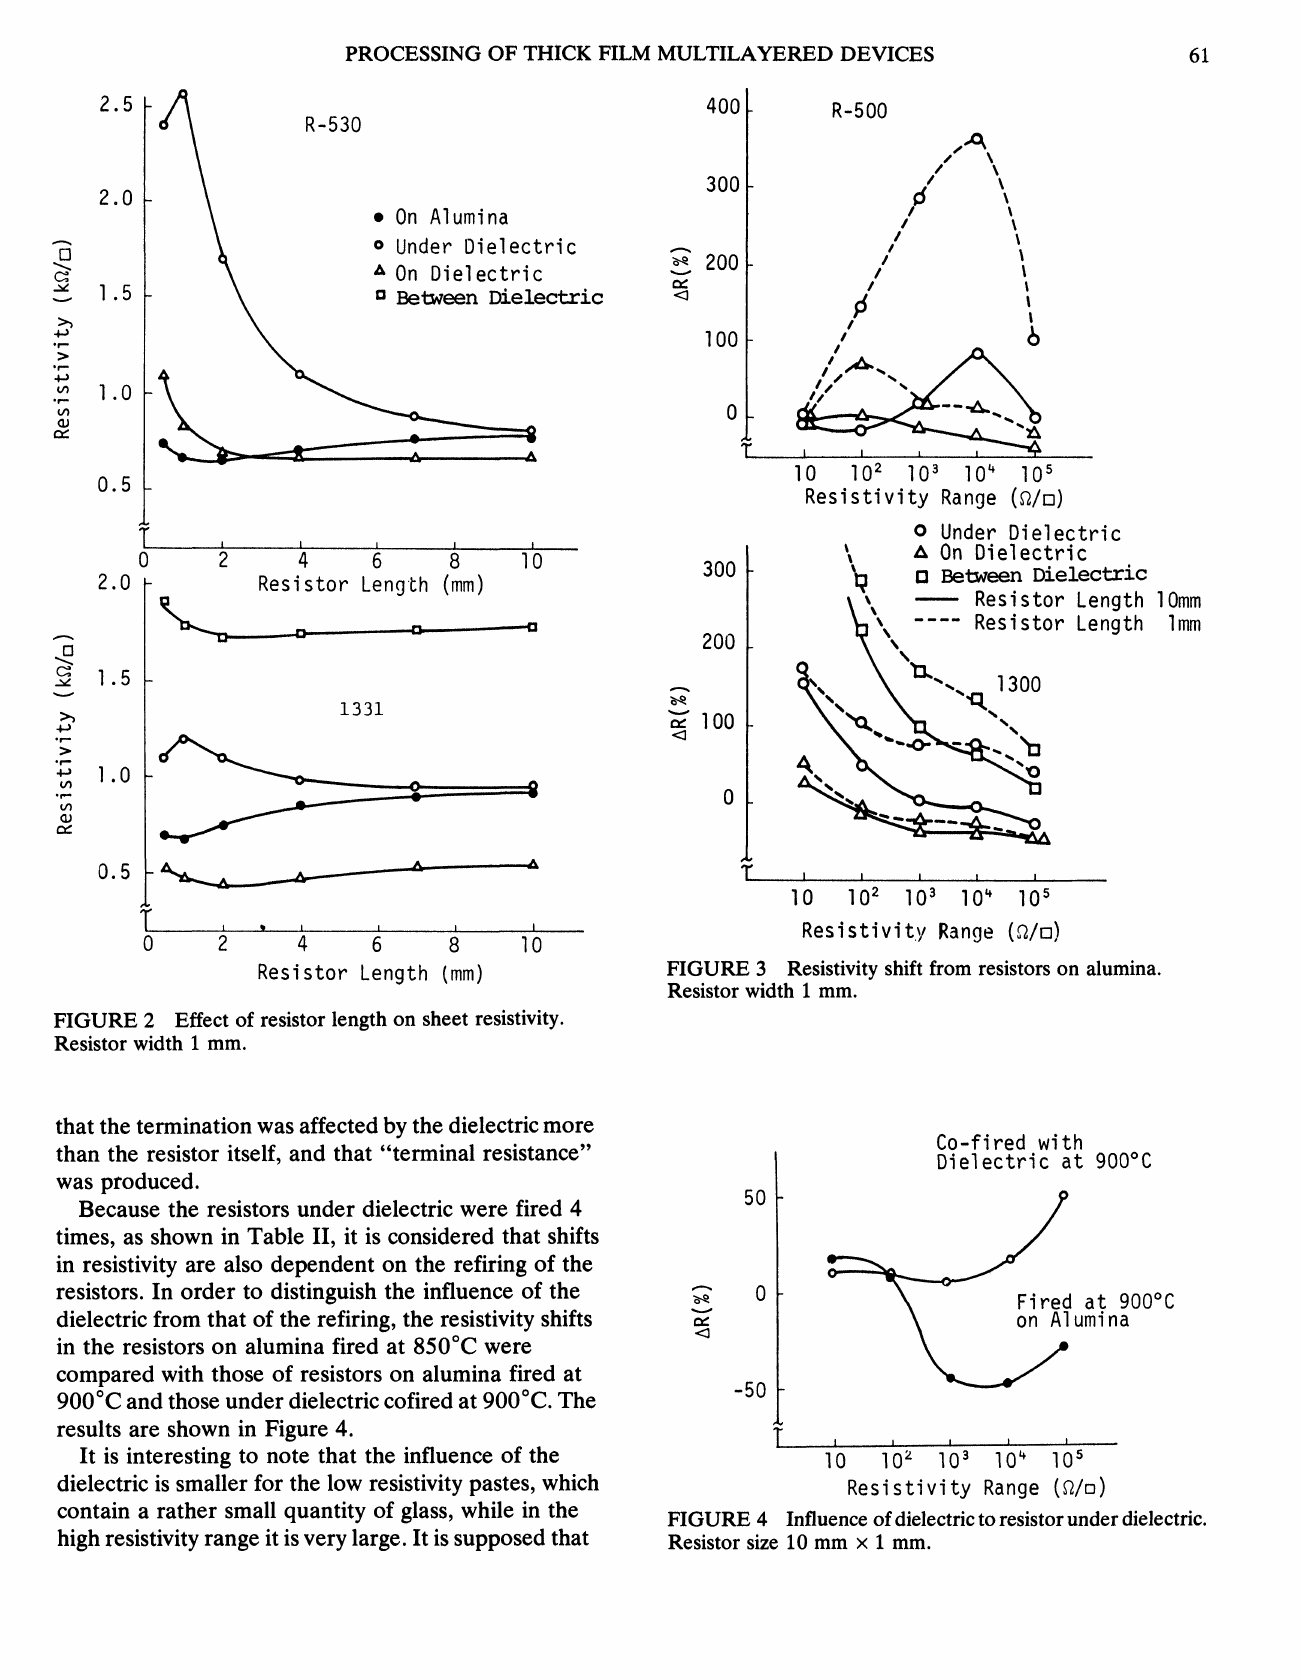
FIGURE 4 Influence of dielectric to resistor under dielectric. Resistor size 10 mm x 1